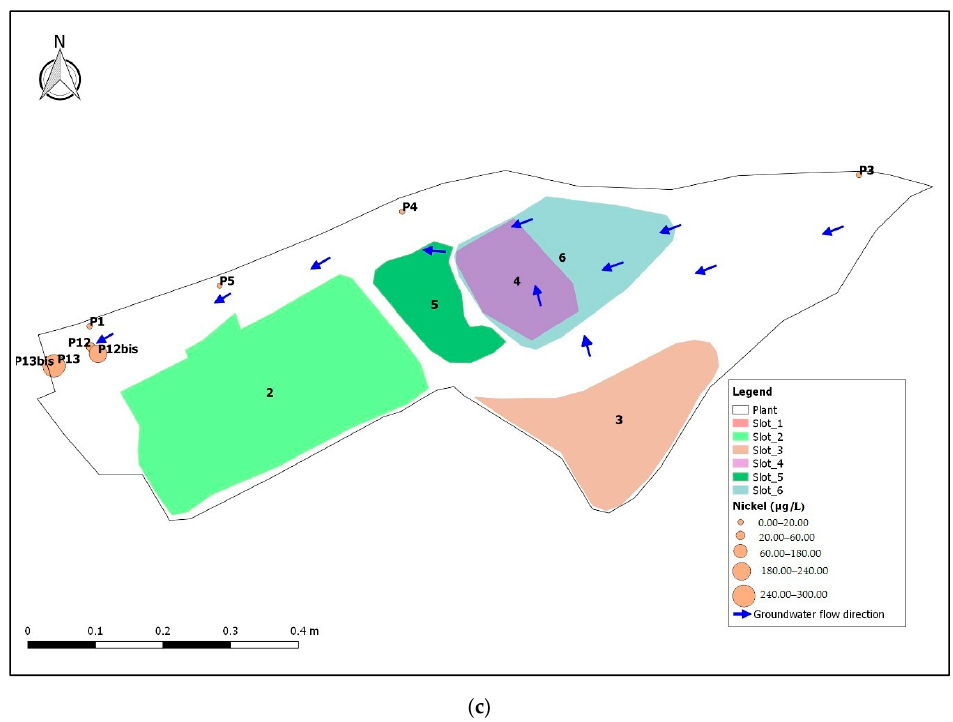
Figure 5. Concentrations spatial trend for the Case History I: ( a ) Iron, ( b ) Manganese, ( c ) Nickel.